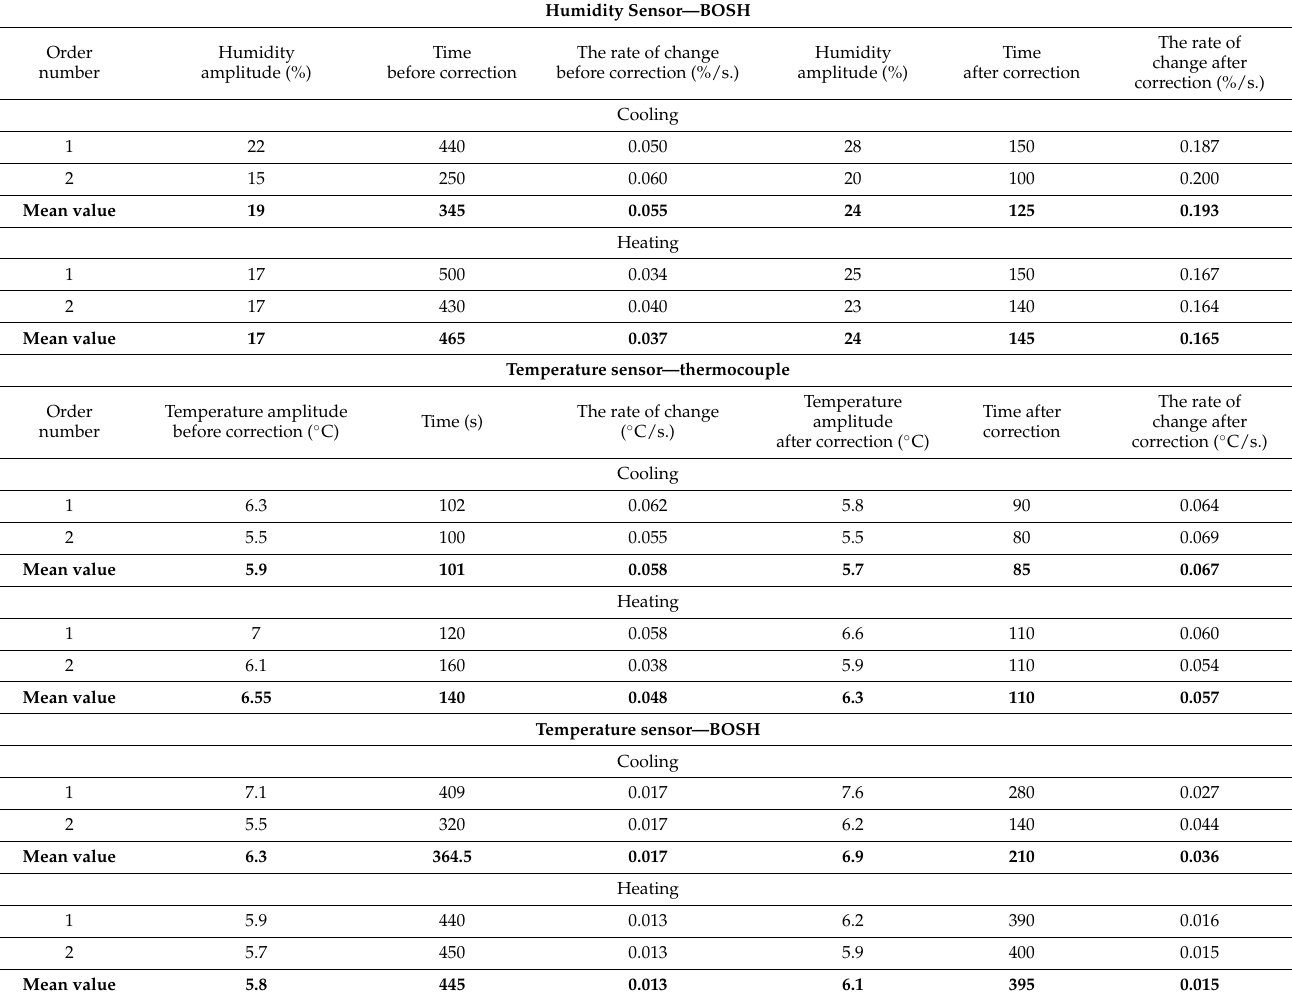
Table A1. Time response of humidity and temperature sensors before and after correction procedure.